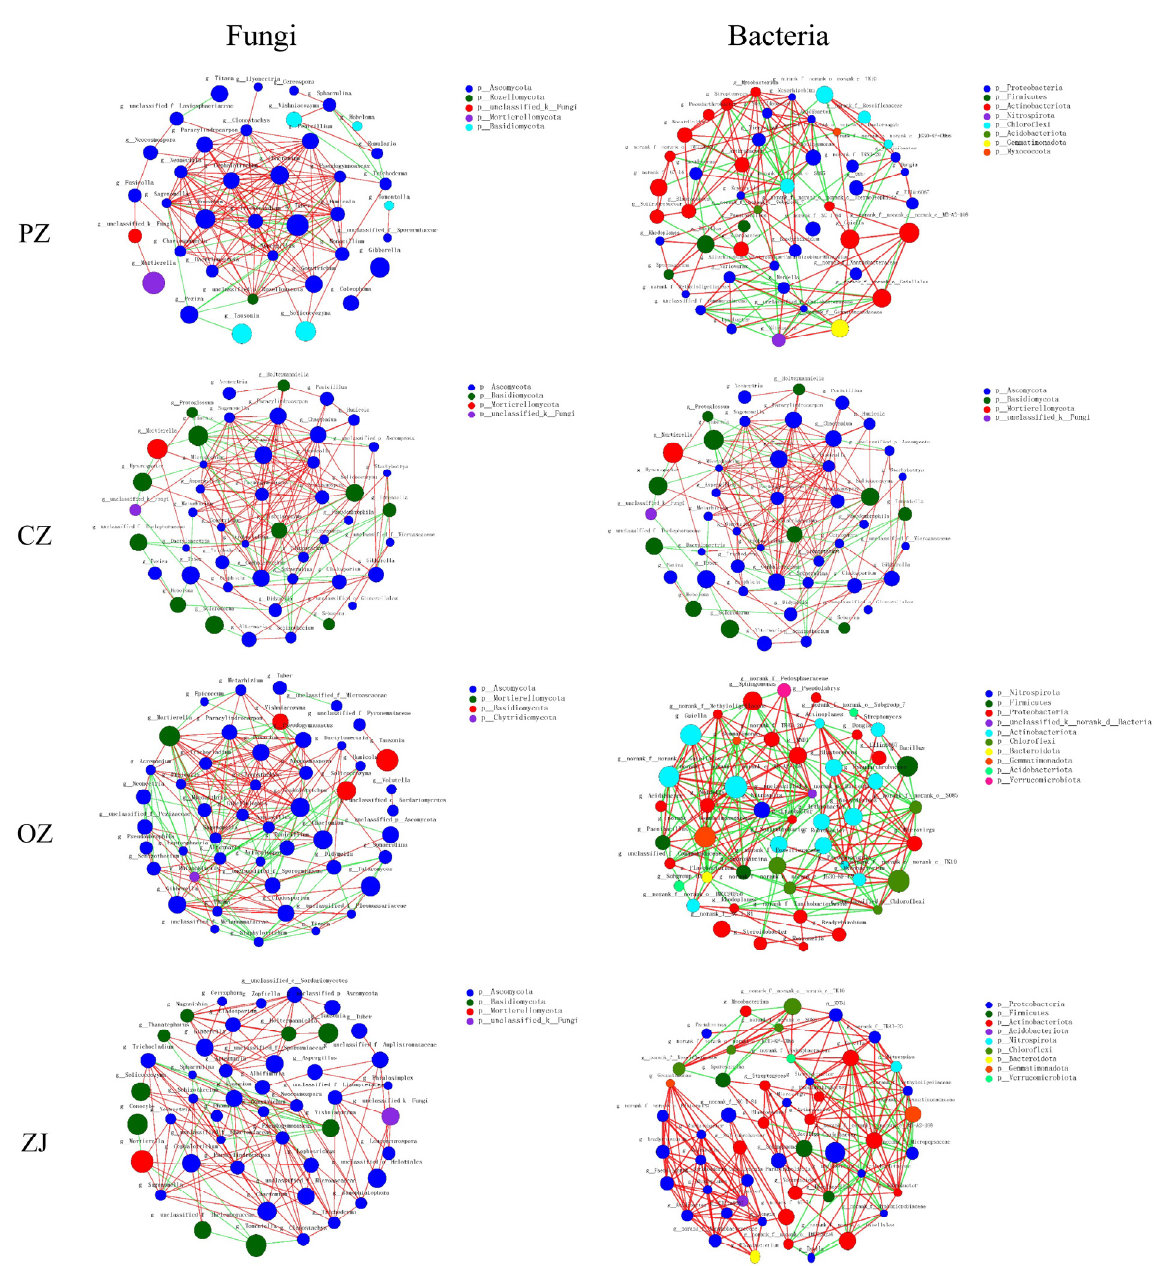
Figure 7. Co-occurrence network of fungal and bacterial communities across four species of the genus Corylus based on correlation analysis. Nodes in the networks are colored by phylum. Connections represent strong (Spearman’s ρ > 0.6) and significant ( p < 0.05) correlations. The edge color represents positive (red) and negative (green) correlations. The size of each node is proportional to the relative abundance of a specific genus. The thickness of each edge is proportional to the ρ . PZ: C . heterophylla ; CZ: C . kweichowensis ; OZ: C . avellane ; ZJ: C . heterophylla × C . avellane .